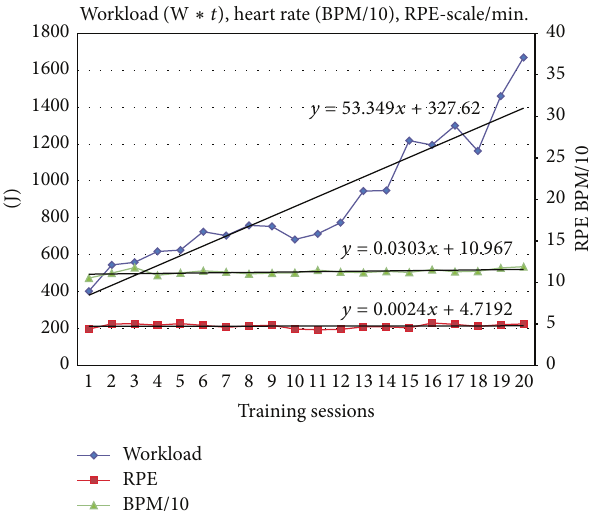
Figure 1: Changes in mean workload, heart rate, and ratings of per- ceived exertion in the training groups during 20 training sessions.